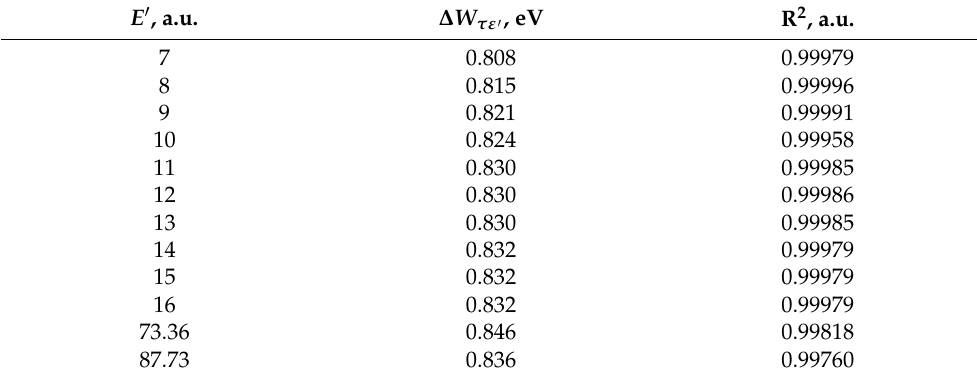
Table 2. Activation energies for the relaxation time of electrical permittivity and determination factors R 2 for the runs shown in Figure